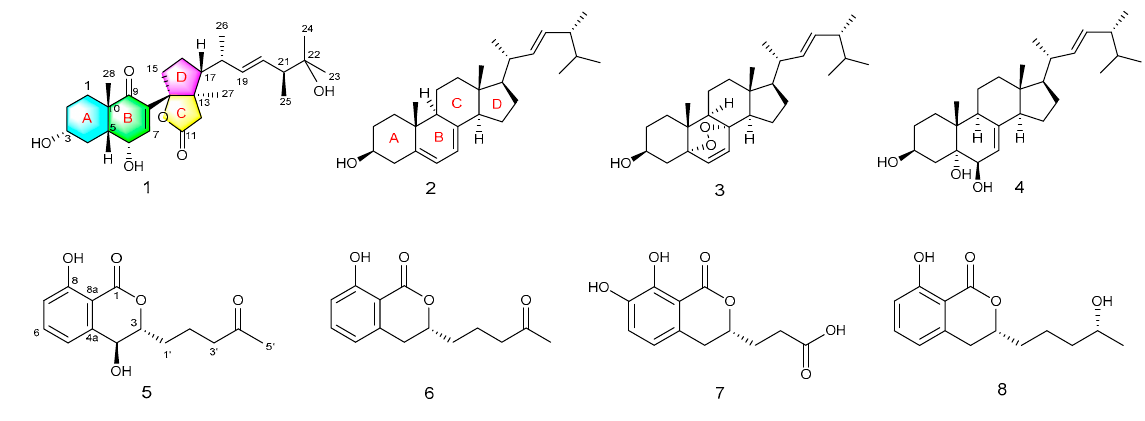
Figure 1. Structure of compounds 1 – 8 .